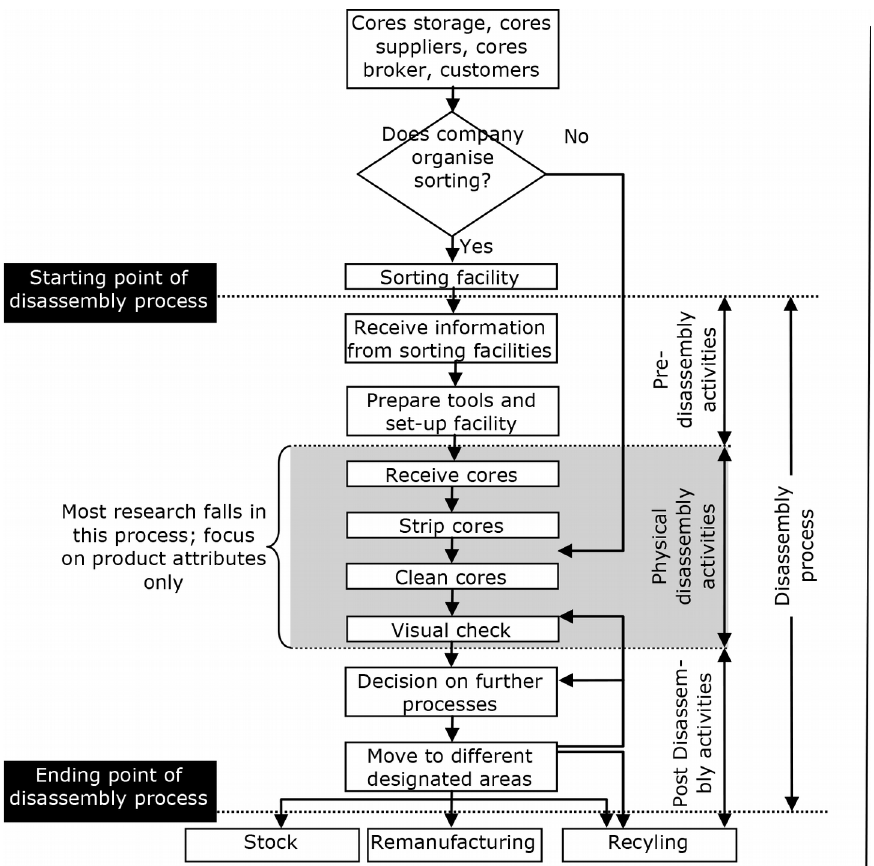
Figure 5. A new model of disassembly for